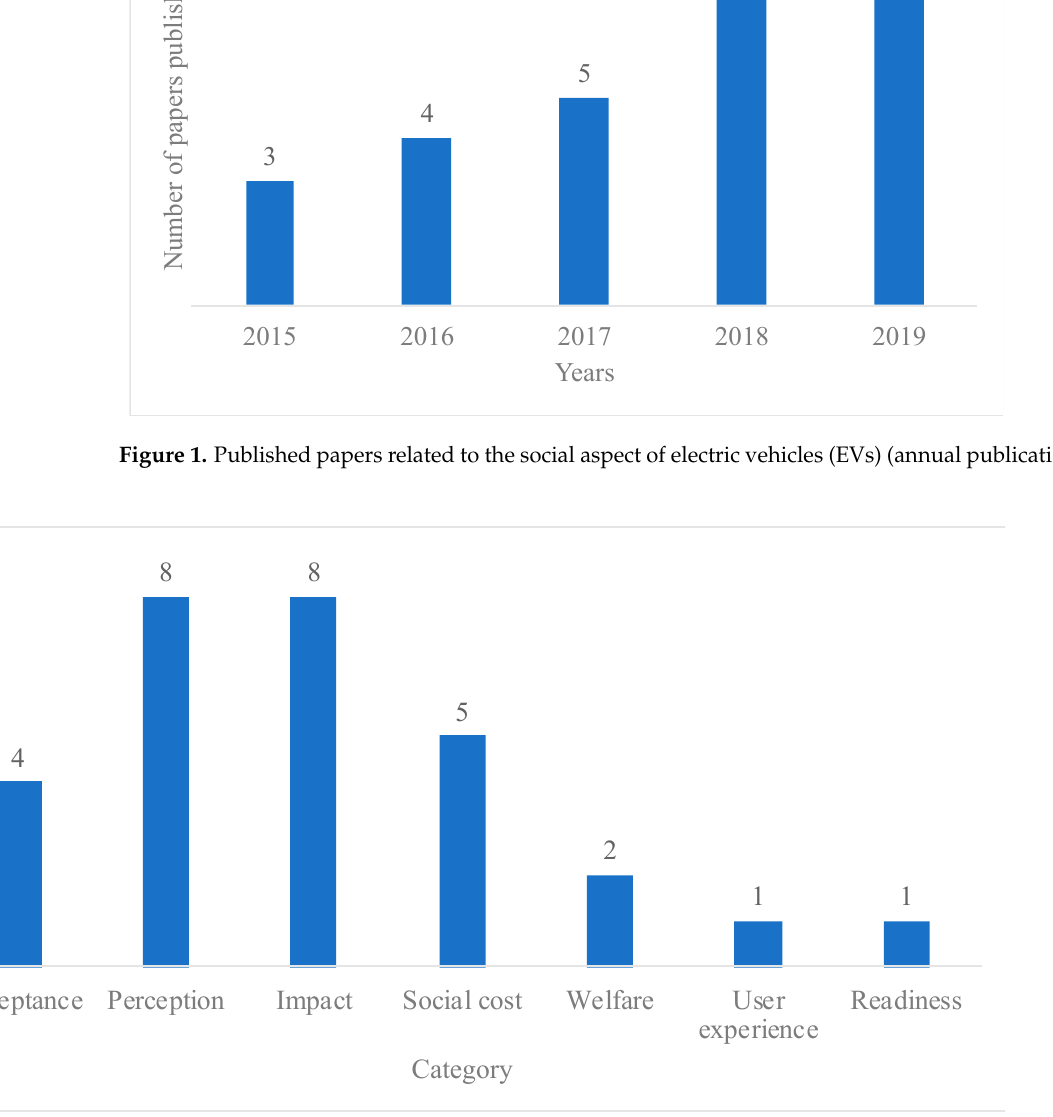
Figure 2. Papers divided in specific categories related to social aspects of EVs.